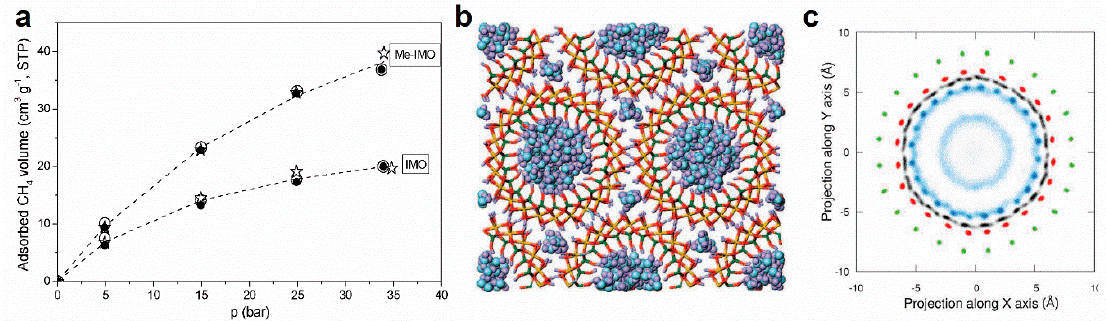
Figure 6. Molecular confinement in imogolite nanotubes. ( a ) Selective molecular sieving towards CH 4 . Adapted from [75]; ( b , c ) Snapshot of fully hydrated INTs and 2D radial density profiles for oxygen (blue) from water molecules. Adapted with permissions from [117,118].